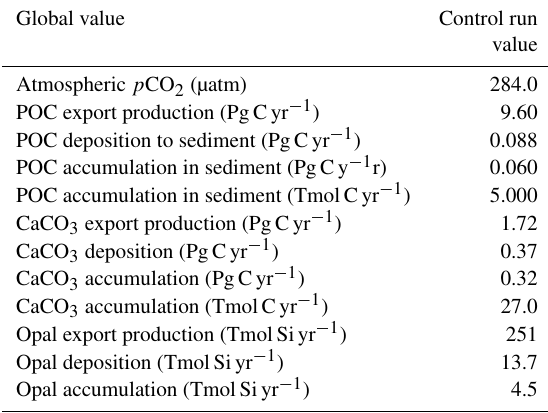
Table 1. Global bulk numbers for the model control